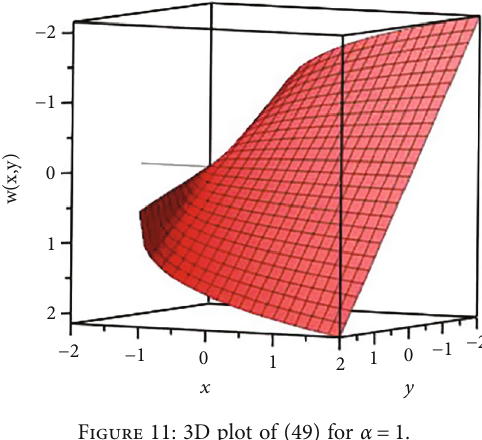
Figure 11: 3D plot of (49) for α = 1 .